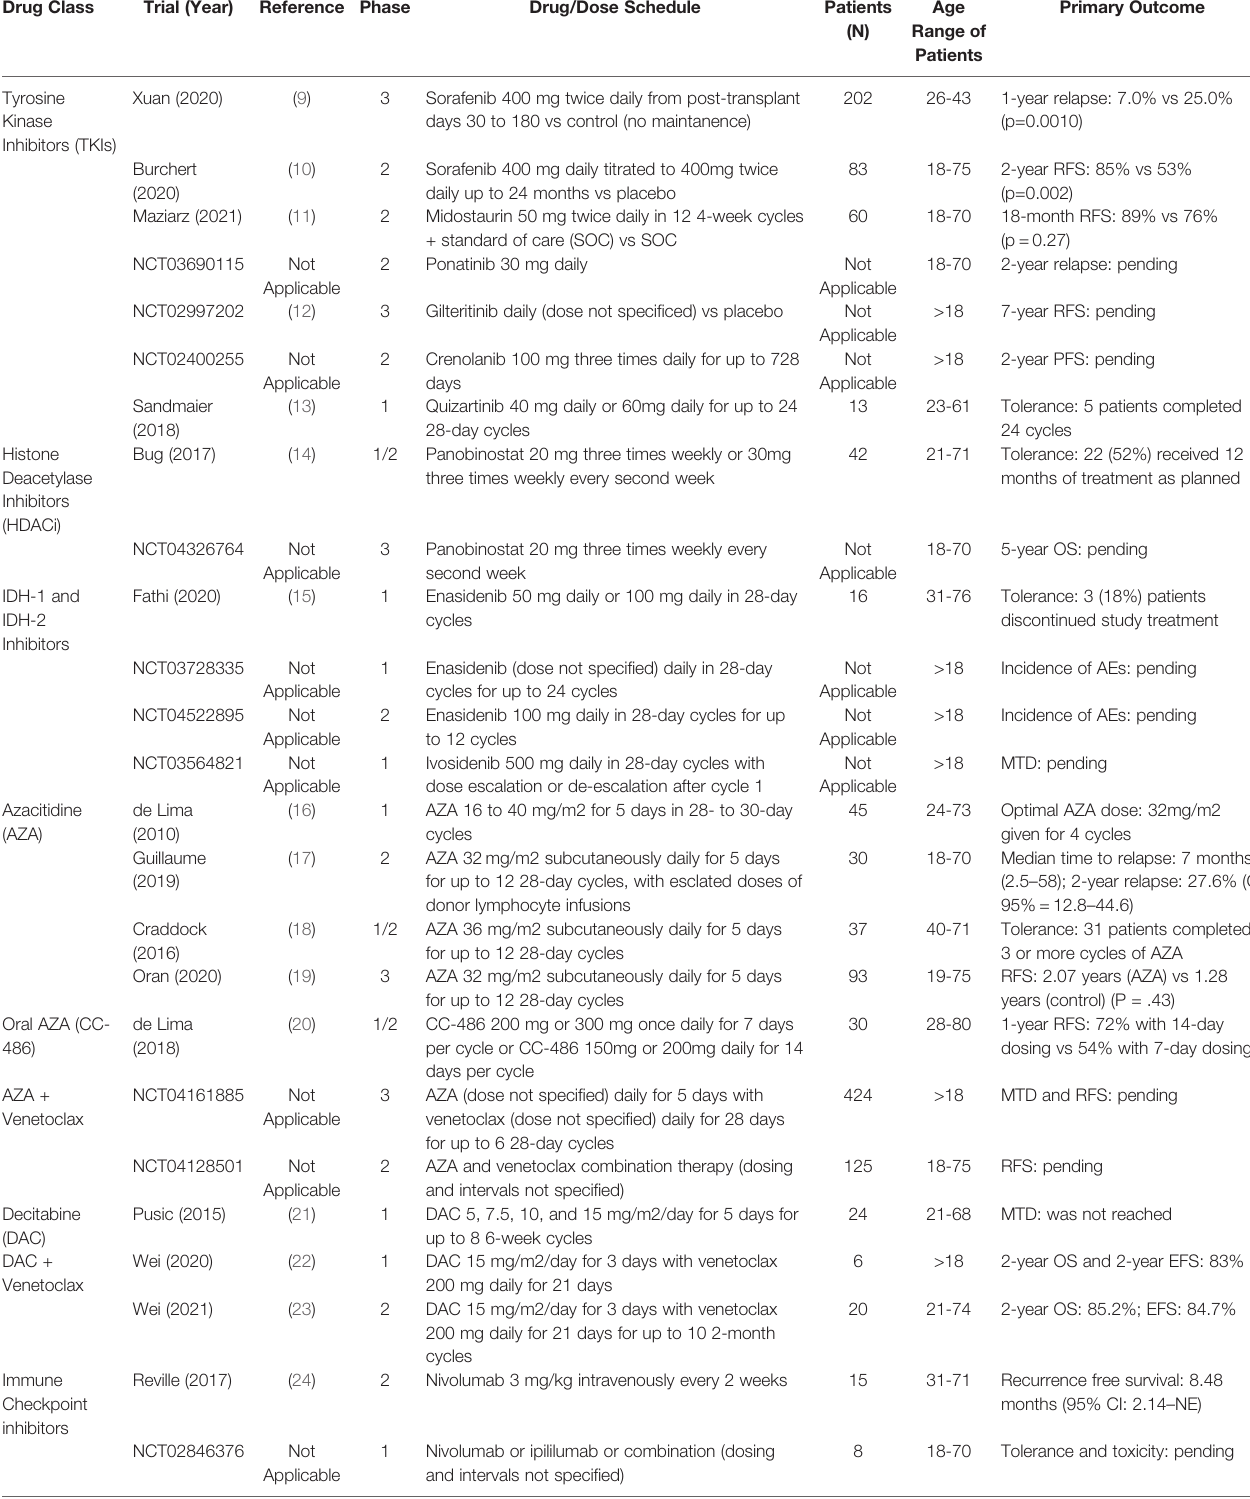
TABLE 1 | Select Studies of Novel Therapeutics as Post-Transplant Maintanence Therapy in AML. Drug